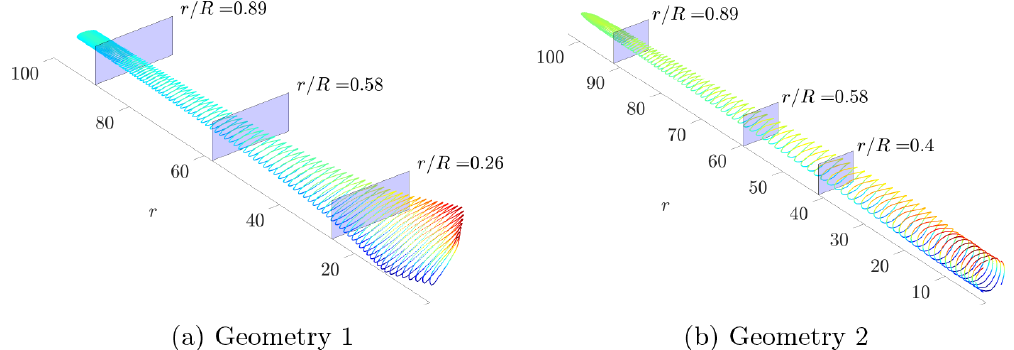
Figure 3. Wind-turbine blades with radial sections of analysis. The surface is colored with a normalized measure of the axial position of the mesh point. The radial coordinate r is given in meters. R is the radius of the wind-turbine